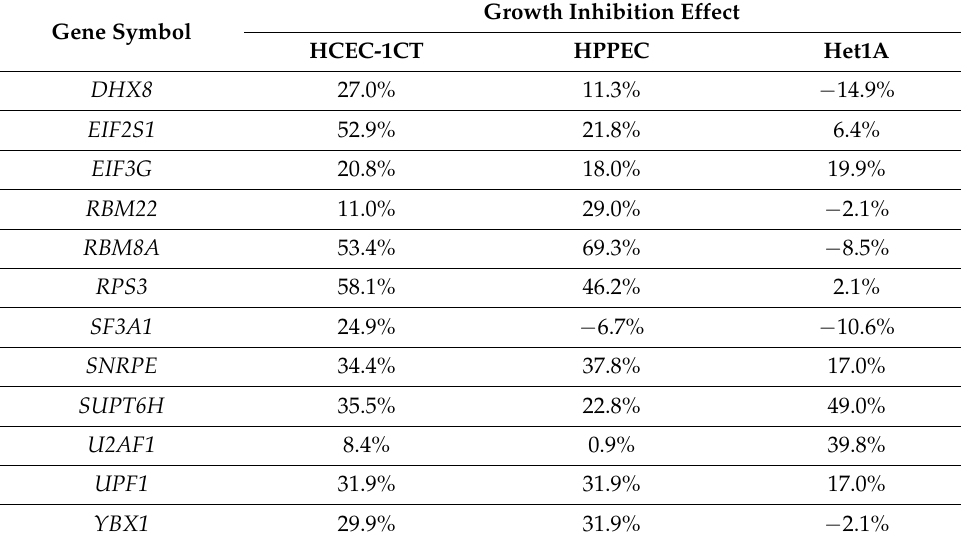
Table 3. The growth inhibition effect in non-cancerous